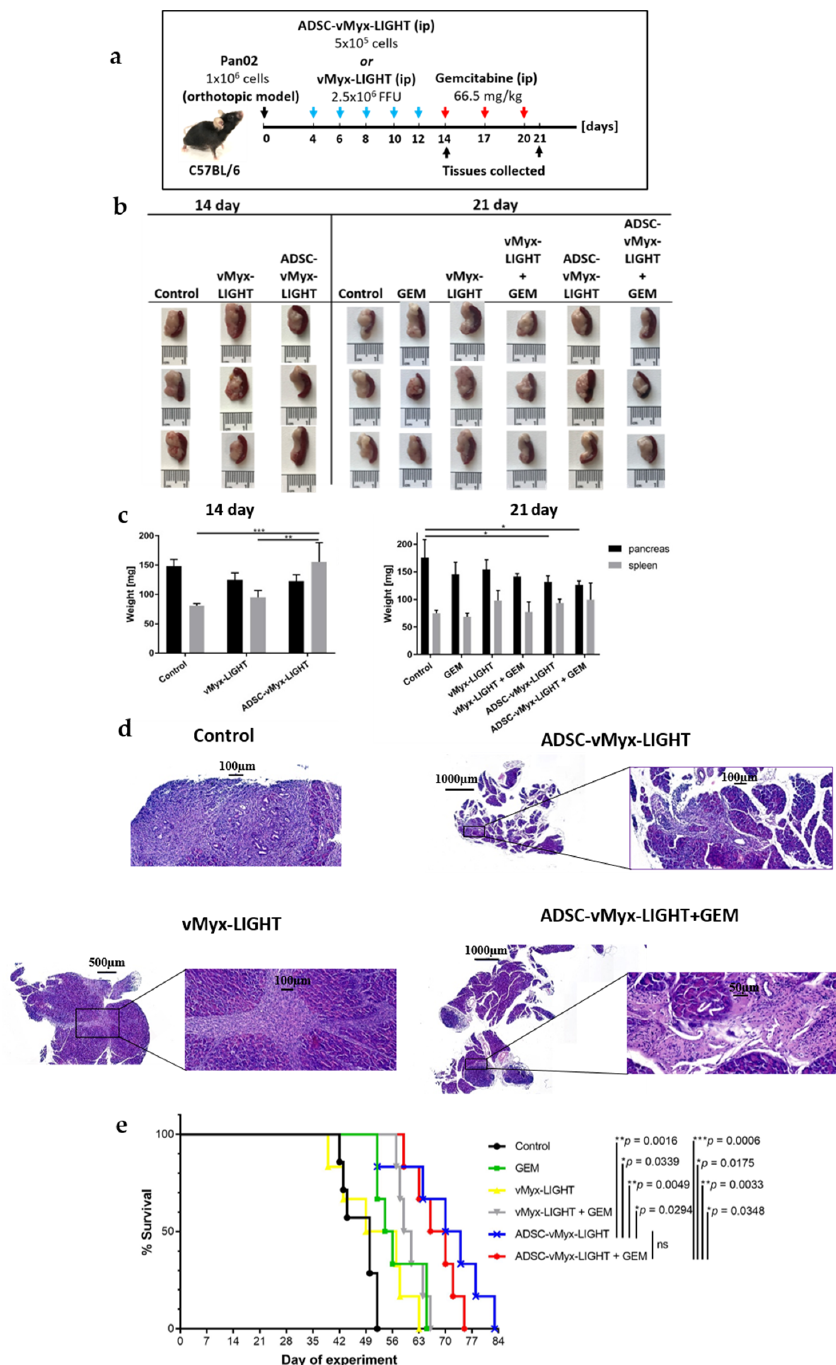
Figure 4. Combined therapy of experimental pancreatic adenocarcinoma using armed MYXV construct. C57Bl/6NCrl mice ( n = 12) with induced orthotopic lesions were injected ip. (days 4, 6, 8, 10 and 12) with LIGHT-expressing MYXV—either ADSC-shielded (5 × 10 5 cells/100 µL PBS¯) or unshielded (2.5 × 10 6 FFU/100 µL PBS¯), and were then injected ip. (days 14, 17 and 20) with GEM (66.5 mg/kg in 100 µL PBS¯). ( a ) Timeline of experiment; ( b ) size and ( c ) weight of pancreata and spleens on days 14 and 21 ( n = 3); ( d ) representative micrographs of H&E-stained sections derived from the indicated treatment groups (scale bars: 50–1000 µm); ( e ) mouse survival ( n = 6): log rank test (Mantel–Cox). The data (mean ± SD) were analyzed with one-way ANOVA; statistically significant differences are indicated (* p ≤ 0.05; ** p ≤ 0.01; *** p ≤ 0.001).